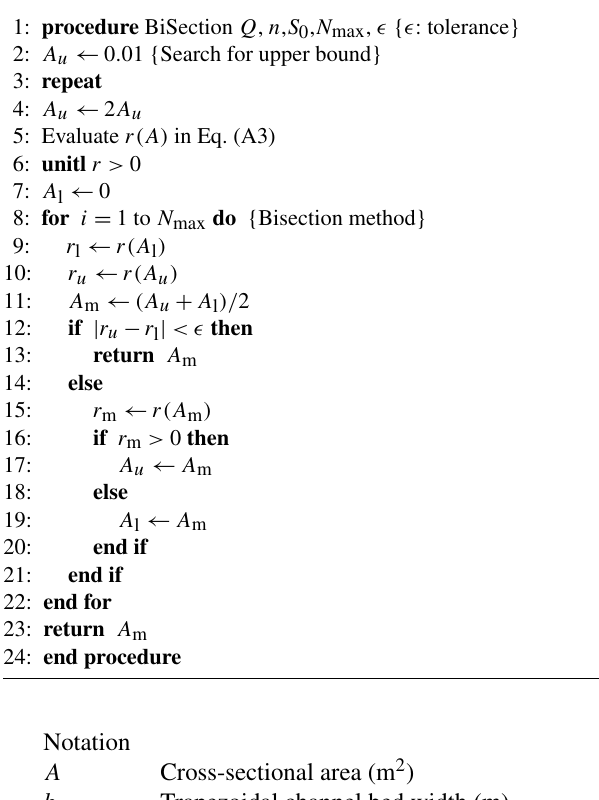
Algorithm 4 Bi-section